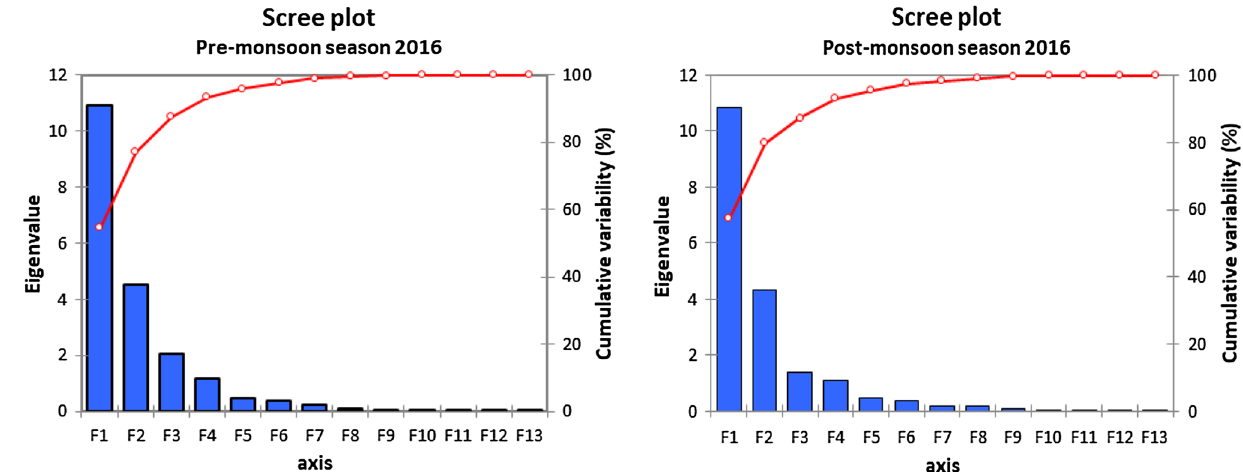
Fig. 7 Scree plots of pre-monsoon and post-monsoon